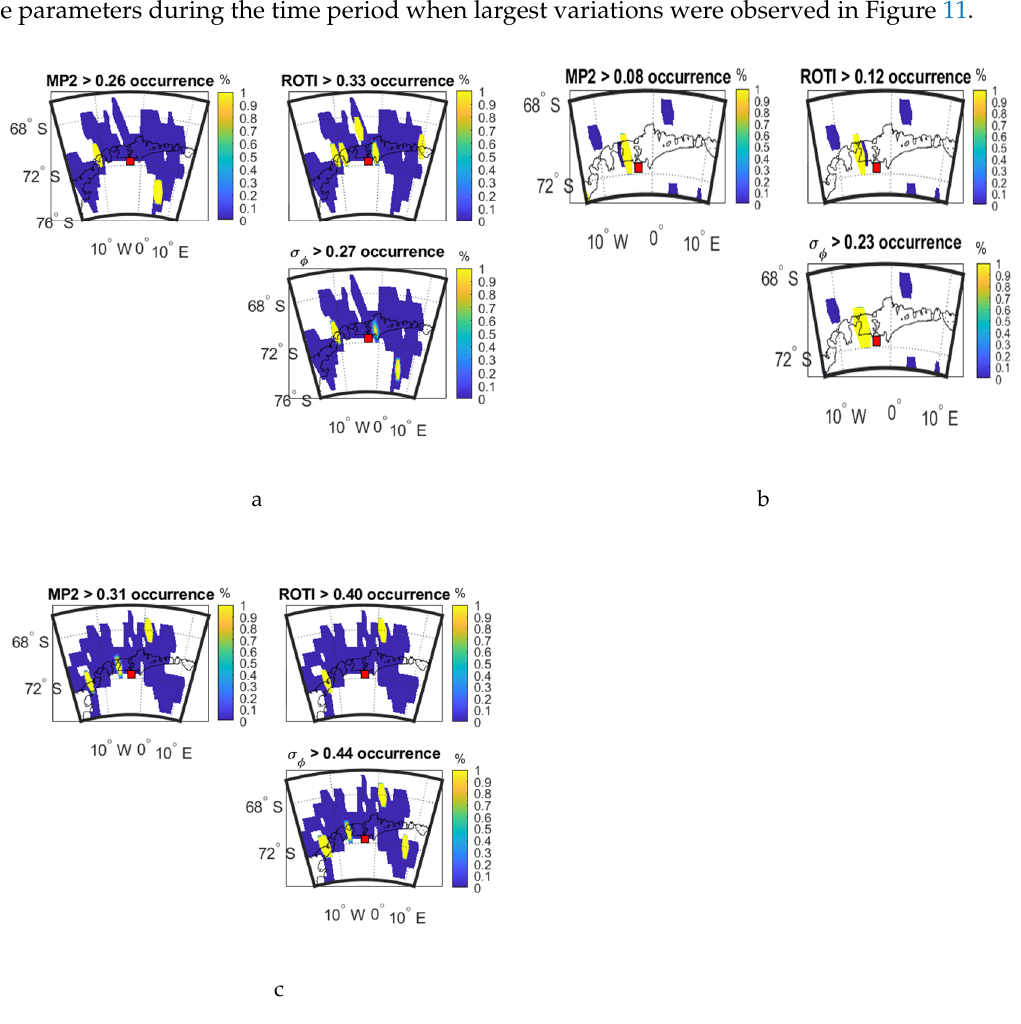
Figure 15. Occurrence percentage maps of three parameters at SNA0P station: ( a ) during